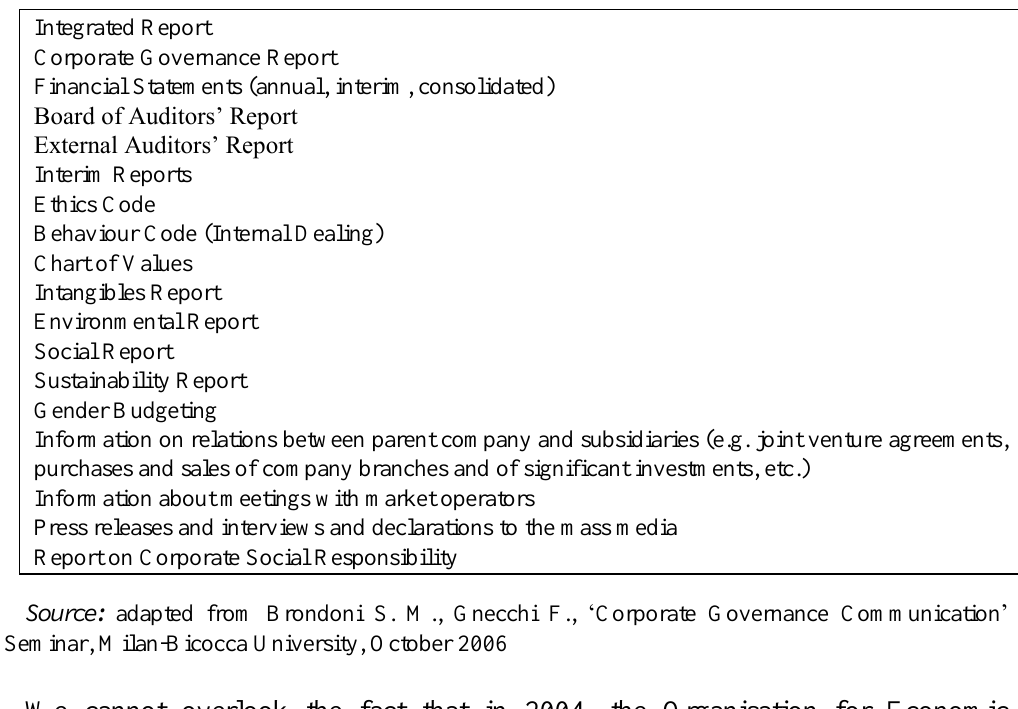
Figure 3: Communication Corporate Governance